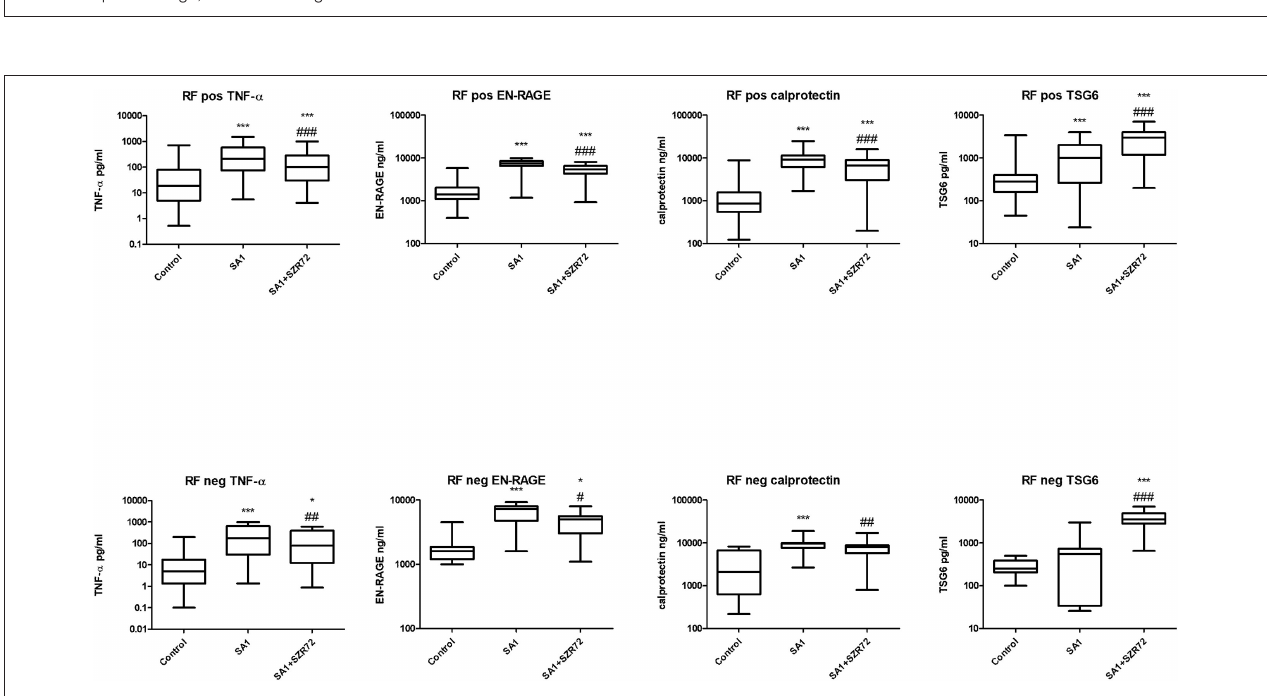
FIGURE 13 | Levels of TNF- α , EN-RAGE, calprotectin, and TSG-6 at baseline and following treatment with SA1 and SA1 + SZR72 in rheumatoid factor (RF) in patients with positive ( n = 72) and negative rheumatoid arthritis (RA) ( n = 17). Comparisons were made with Friedman’s tests * p < 0.5 vs. control, *** p < 0.001 vs. control, # p < 0.05 vs. SA1, ## p < 0.01 vs. SA1, ### p < 0.001 vs. SA1. Horizontal line—median, box—interquartile range, whiskers—range.